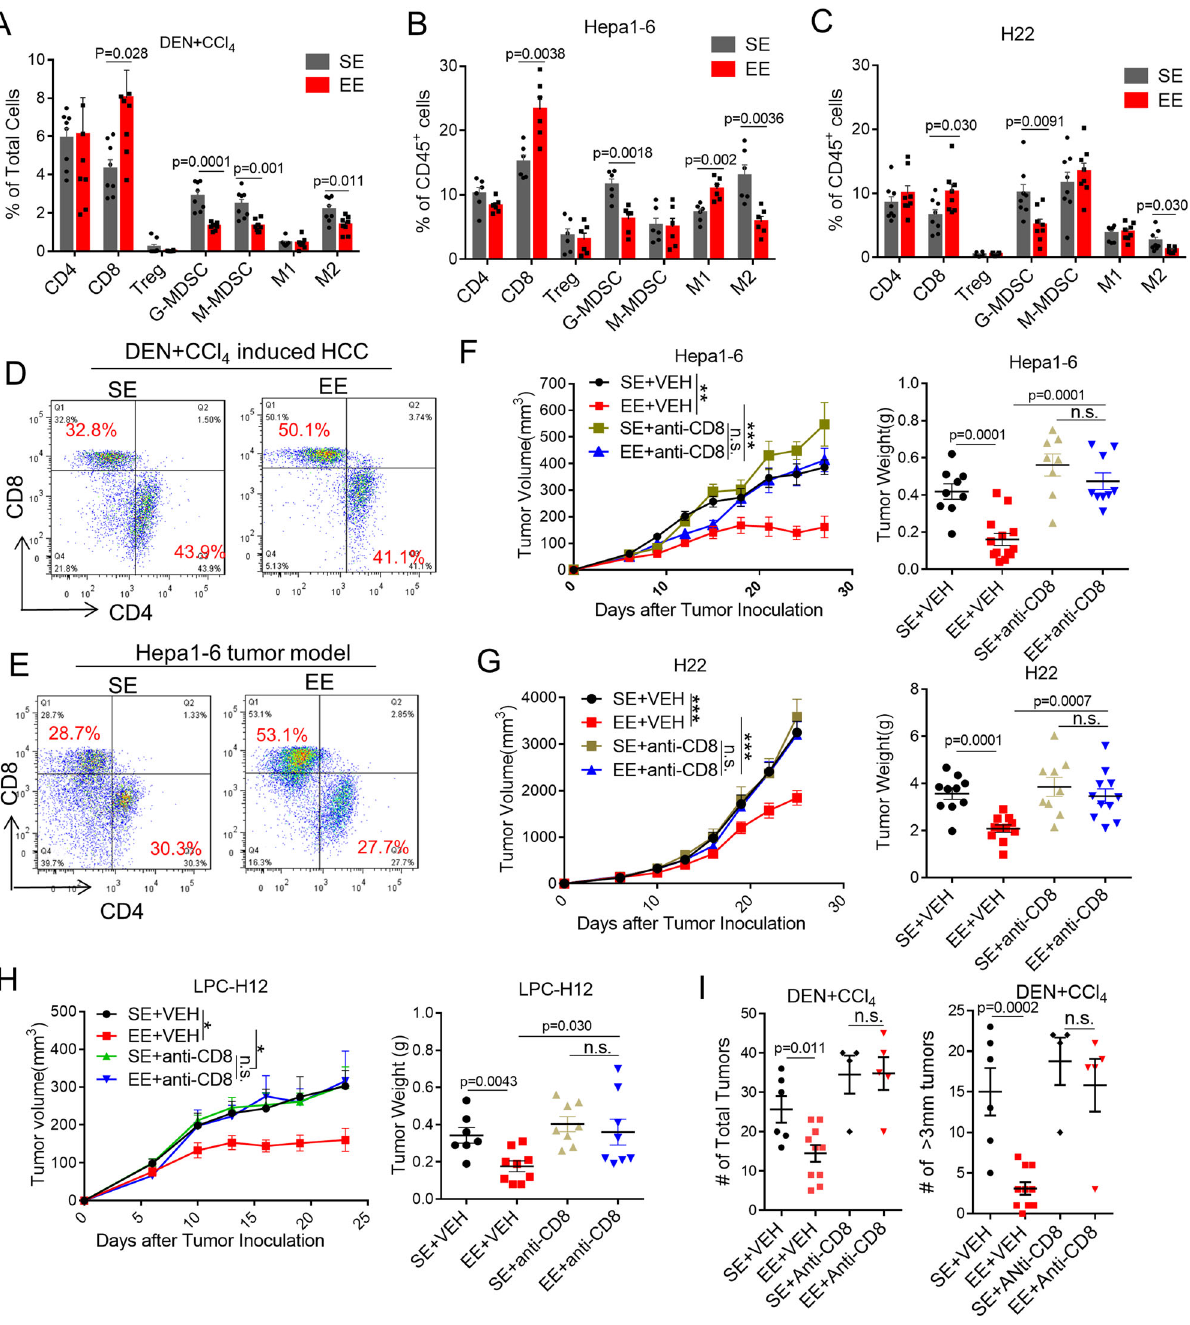
Fig. 2 Environmental eustress reshapes tumor microenvironment and reduces tumor growth dependent on CD8 + T cells. A – C Different in fi ltrated immune cells within tumor microenvironment were analyzed by fl ow cytometry from mice tumors in DEN + CCl 4 model A , and Hepa1-6 model B , and H22 model C ( n = 8 for each group). SE standard environment, EE enriched environment. All data are presented as the mean ± SEM, and analyzed by two-tailed unpaired Student ’ s t test. D, E Representative fl ow cytometric analyses of CD4 + and CD8 + T cells in tumor tissues from DEN + CCl 4 -induced tumor model D and Hepa1-6 tumor model E . F – H Tumor volume and tumor weight of subcutaneous Hepa1-6 F , H22 G , and LPC-H12 H tumors in mice treated with anti- CD8 neutralization antibody (anti-CD8) or vehicle (VEH) under SE or EE-feeding conditions (SE + VEH: n = 9, EE + VEH: n = 13, SE + anti-CD8: n = 8, EE + anti-CD8: n = 9 for Hepa1-6 groups; SE + VEH: n = 10, EE + VEH: n = 11, SE + anti-CD8: n = 9, EE + anti-CD8: n = 11 for H22 groups; SE + VEH: n = 7, EE + VEH: n = 9, SE + anti-CD8: n = 8, EE + anti-CD8: n = 8 for LPC-H12 groups). All data are presented as the mean ± SEM, and analyzed by two-tailed unpaired Student ’ s t test with n.s., p > 0.05; * p < 0.05; ** p < 0.01, *** p < 0.001. I Total tumor number and diameter ø ≥ 3 mm tumor number in the liver of DEN + CCl 4 -treated mice with CD8 + T cells depletion under SE or EE-feeding conditions (SE + VEH: n = 6, EE + VEH: n = 10, SE + anti-CD8: n = 4, EE + anti-CD8: n = 5). All data are presented as the mean ± SEM, and analyzed by two-tailed unpaired Student ’ s t test.